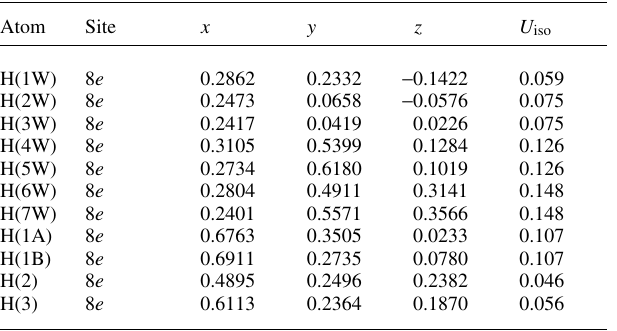
Table 2. Atomic coordinates and displacement parameters (in Å 2 )